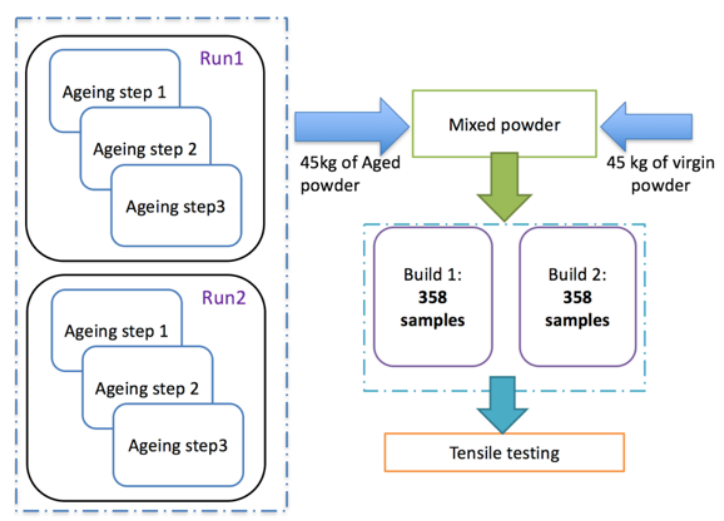
Figure 2. Schematic representation of main stages of the experiment.